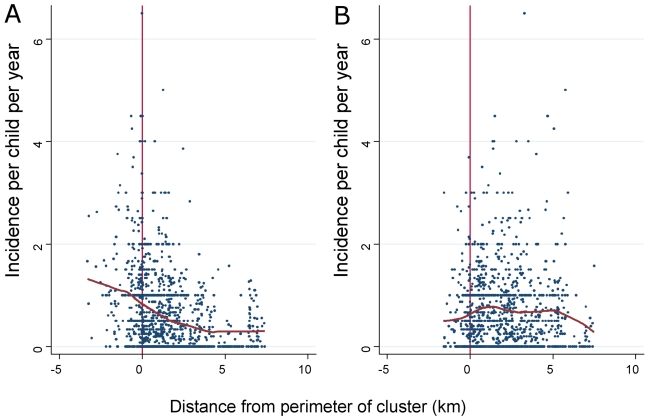
The incidence of febrile malaria for each homestead is plotted against distance from the perimeter of the cluster for (A) clusters of febrile malaria and (B) clusters of asymptomatic parasitaemia.Negative distances indicate a location inside the cluster, and positive distances indicate a location outside. Loess curves are shown in red (using a bandwidth of 0.8).